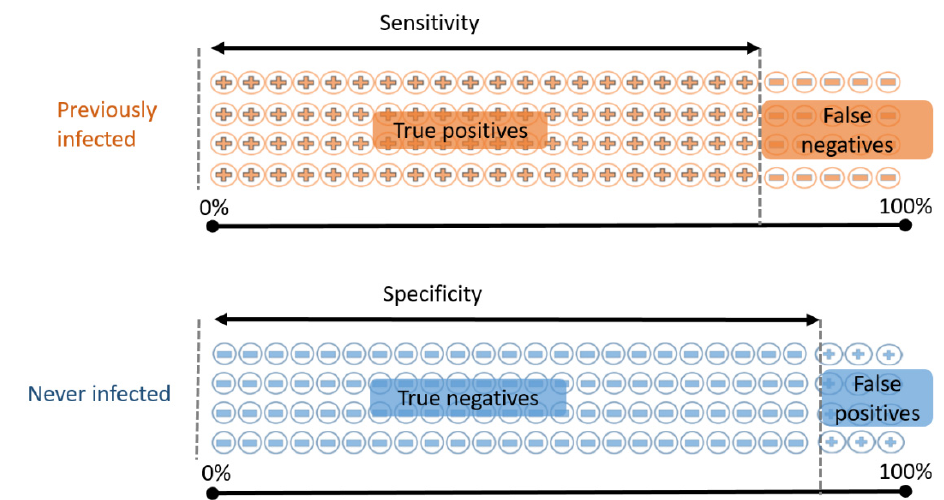
Figure 4. Sensitivity and specificity of a SARS-CoV-2 antibody test. In a sample of previously infected people, some will correctly test positive (true positives) while others will incorrectly test negative (false negatives)—sensitivity refers to the proportion of previously infected people who correctly test positive. Similarly, never-infected people may correctly test negative (true negatives), or incorrectly test positive (false positives)—specificity is the proportion of never-infected people who correctly test negative.